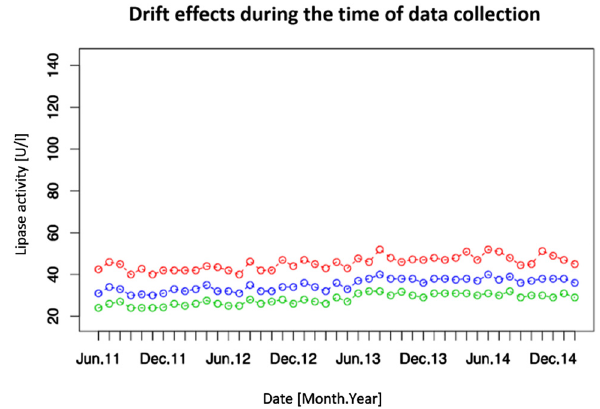
Figure 1: Time drift during data collection (n=29.841, all): 25th (green), 50th (blue) and 75th (red) percentile; months.